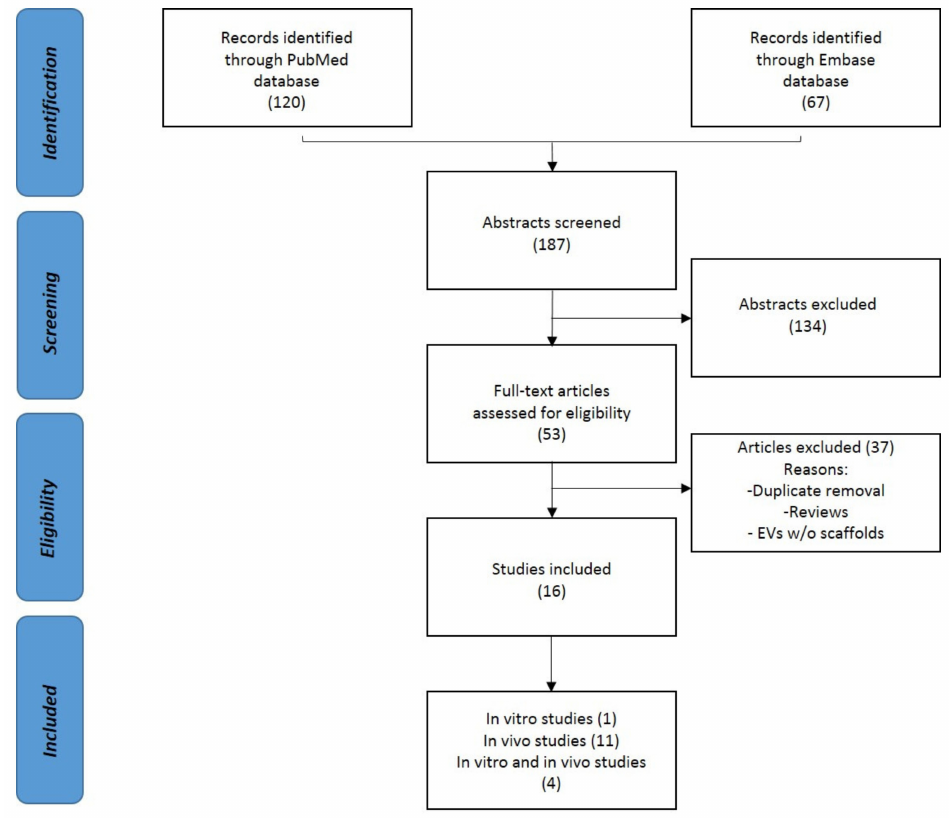
Figure 2. PRISMA (Preferred Reporting Items for Systematic Review and Meta-Analysis) flowchart of the systematic literature